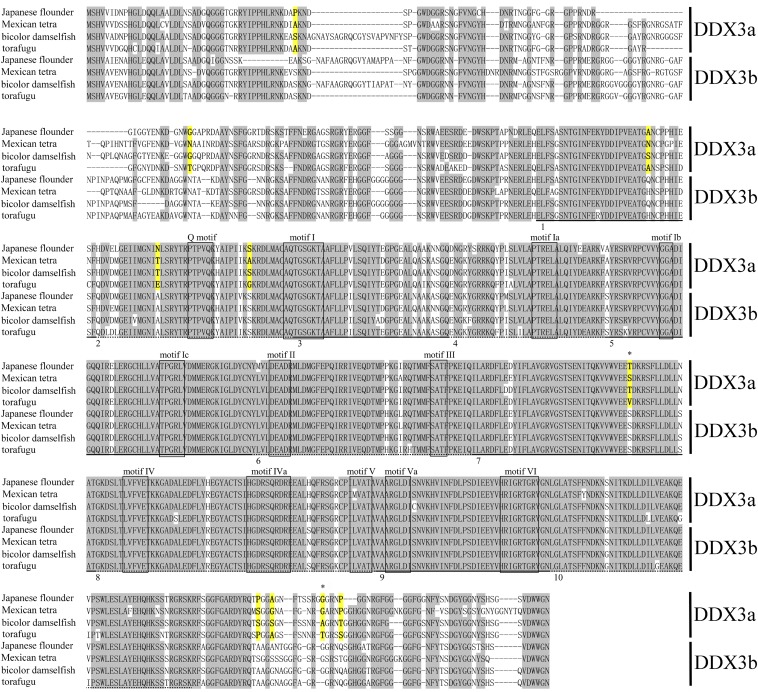
Alignment of the deduced amino acid sequences of teleost Ddx3 genes. Identical amino acids are in gray background. Amino acid sequences with identical underline are encoded by the same exon. Numbers 1−10 stand for the ten exons of uniform size and position in both Ddx3a and Ddx3b genes. The 12 conserved motifs characteristic of DEAD-box proteins are boxed. Amino acid sites under positive selection are in yellow background. Asterisk stand for posterior probability > 0.95.